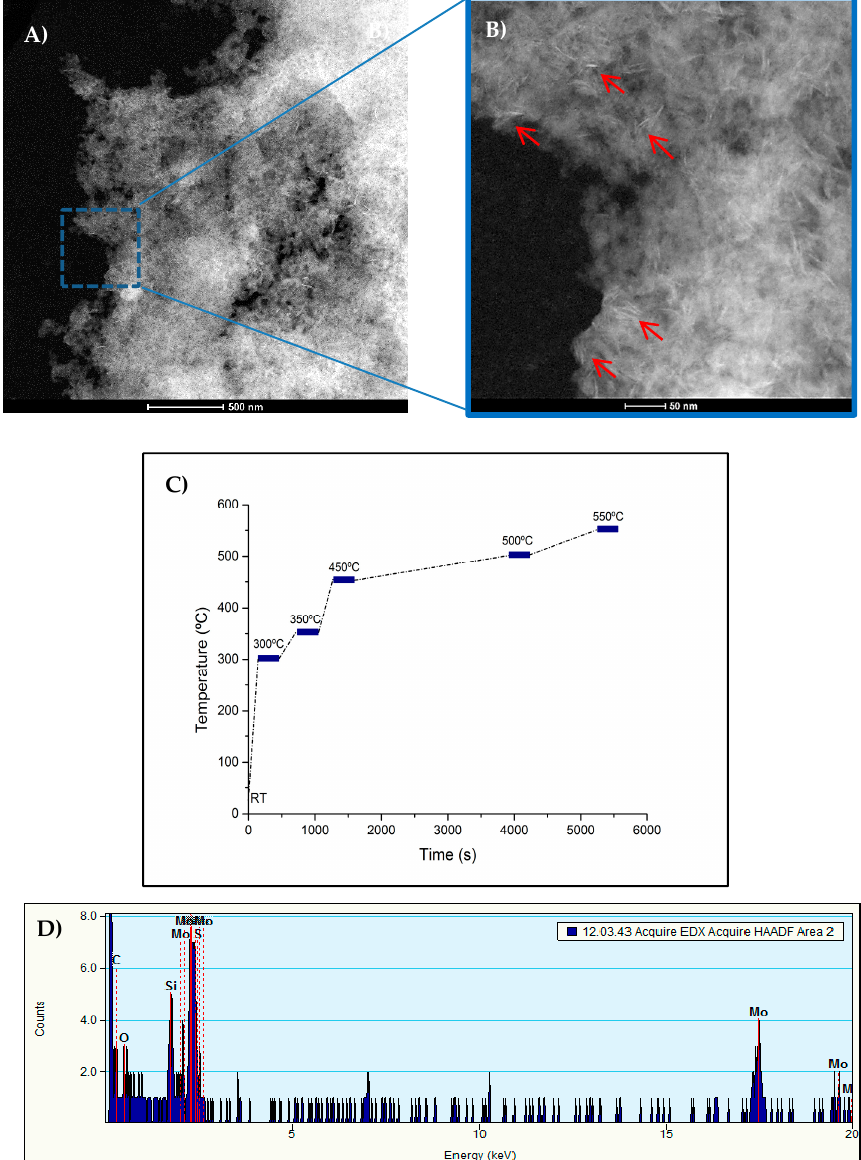
Figure 1. ( A ) Scanning transmission electron microscopy (STEM) image at 28.5kx. ( B ) STEM image at 160kx corresponding to blue square location as presented in ( A ). ( C ) Heating profile used during in-situ STEM heating experiment. ( D ) Spotted chemical composition of the sample by energy dispersed x-ray spectroscopy (EDS).